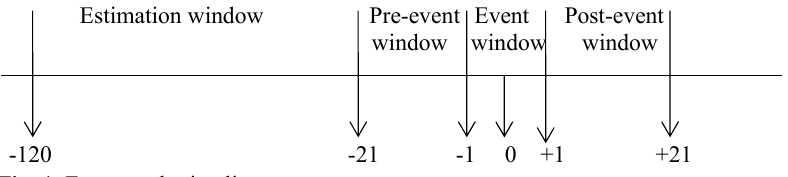
Fig. 1. Event study timeline Note: The prior estimation window is from -120 to 0. From -21 to -1 is the pre-event window, 0 is the event window (such as COVID-19 announcement, COVID-19 infection, COVID-19 death, and vaccination), and +1 to +21 is the post-event